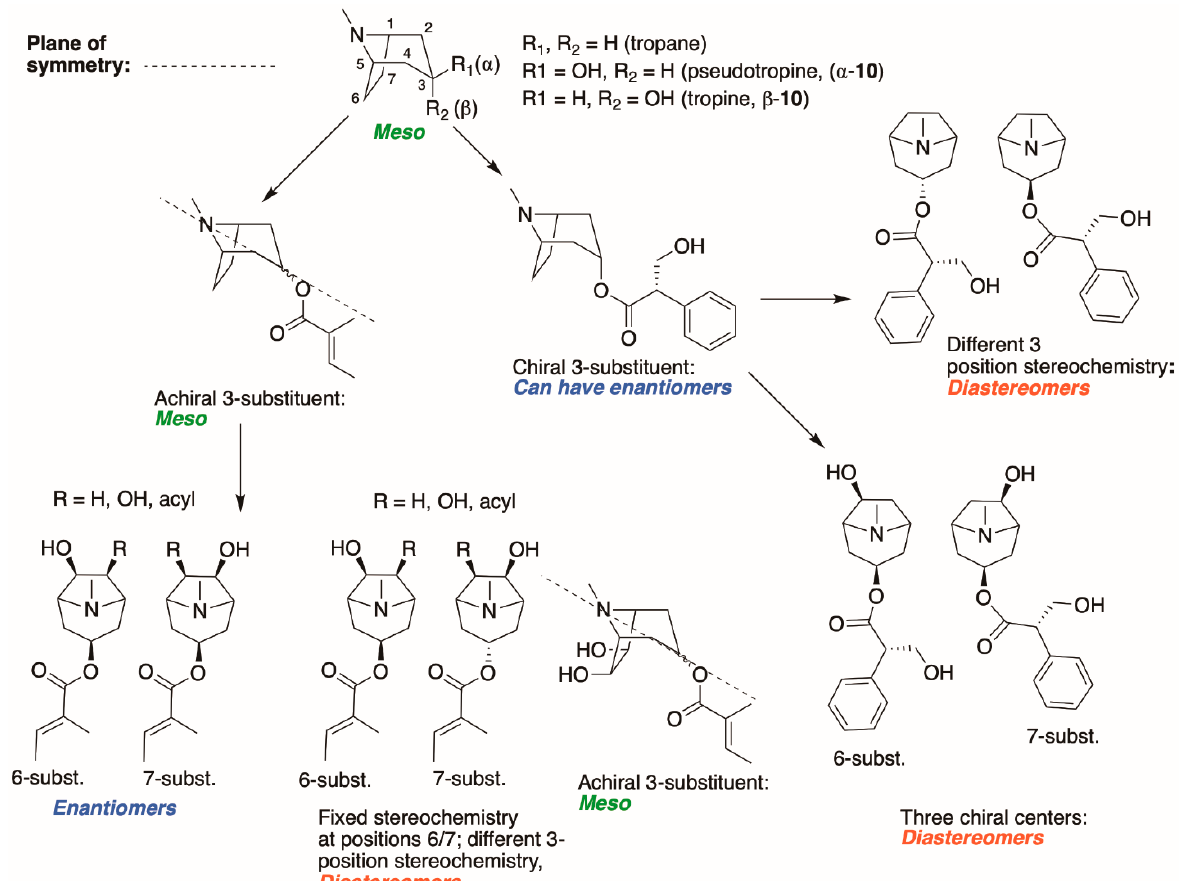
Figure 5. Chirality in tropane alkaloids and relationships between meso compounds, enantiomers, and diastereomers for substituted tropanes.